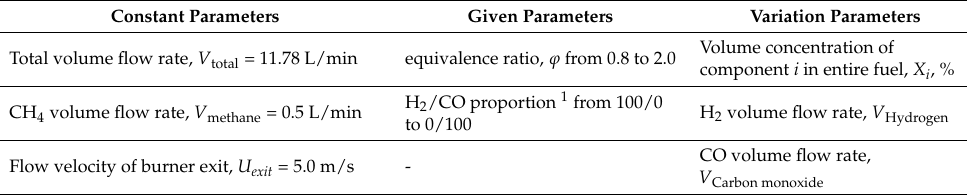
Table 1. Setup of experimental